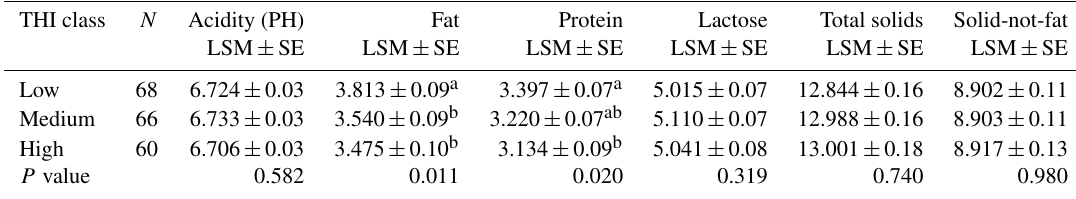
Table 5. Effect of THI on milk chemical compositions (%) in Maghrebi camels. THI class N Acidity (PH) Fat Protein Lactose Total solids Solid-not-fat LSM ± SE LSM ± SE LSM ± SE LSM ± SE LSM ± SE LSM ± SE Low 68 Medium P